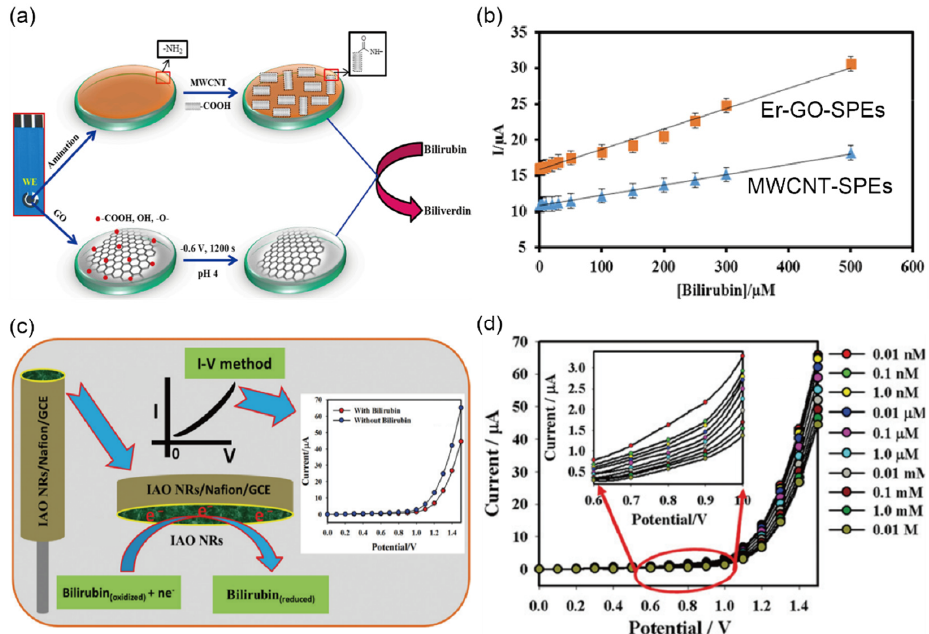
Figure 8. Selective detection of bilirubin (BR) in clinical samples using electrochemical biosensors ( a ) Schematic diagram representing a proposed procedure for multi-walled carbon nanotubes (MWCNTs) screen-printed carbon electrodes (SPEs) and electrochemically reduced graphene oxide (Er-GO) SPE bilirubin sensors for detecting BR. ( b ) Calibration curve of MWCNT-SPEs and Er-GO-SPEs showing the current response at various concentrations of BR (reprinted with permission from Ref. [43]; copyright 2018, MDPI). ( c ) Illustration of the sensing flow to detect BR on a modified glassy carbon electrode (GCE). Top ‐ right inset shows the I–V response with (red dots; 1 µM, 25 µL) and without (blue dots) BR from aqueous solutions. A significantly low current response was observed due to the reduction reaction of BR on the IAO NRs/GCE surface. ( d ) I–V response curve of different aqueous BR concentrations from 0.01 nM to 0.01 M in 5.0 mL of PBS with various potentials from 0.0 to 1.4 V at − 0.2 V steps. The current response slowly decreased as the concentrations of BR increased. The inset shows the magnified view of the current variations for +0.6 to +1.0 V (reprinted with